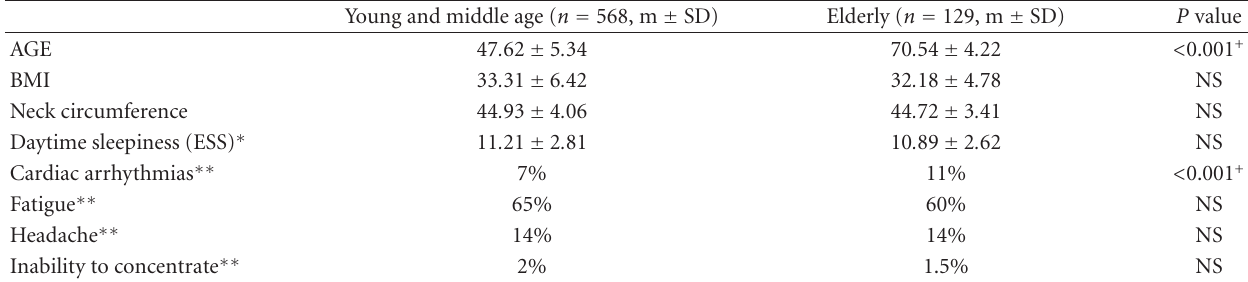
Table 1: Demographic and clinical characteristics of Greek male patients with OSAS.